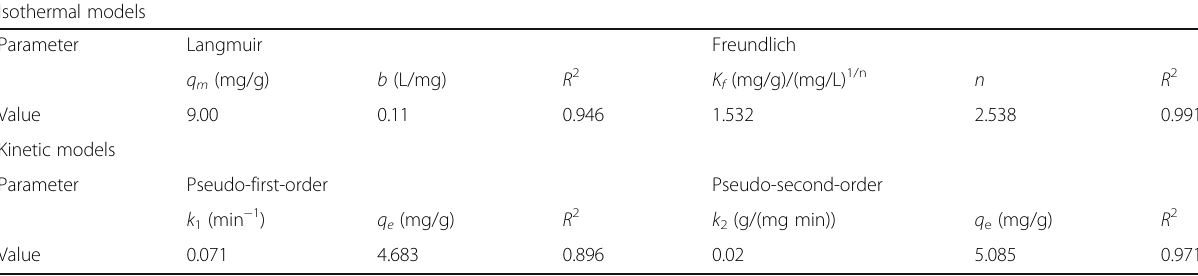
Table 2 Isothermal and kinetic parameters of Pd(II) on Pd(II) IIPs Isothermal